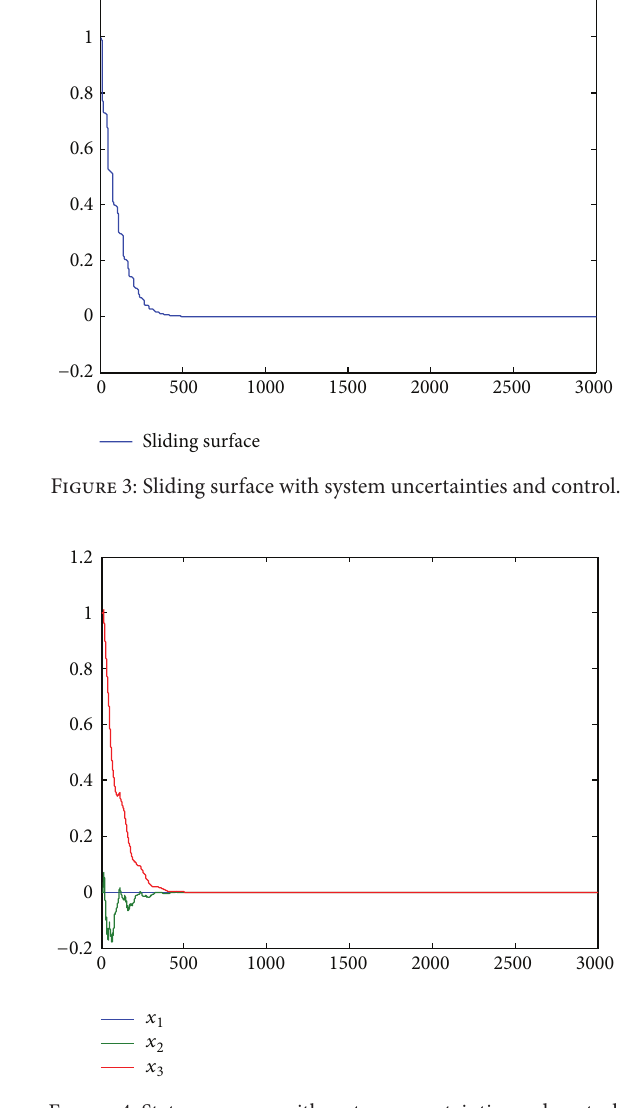
Figure 4: State responses with system uncertainties and